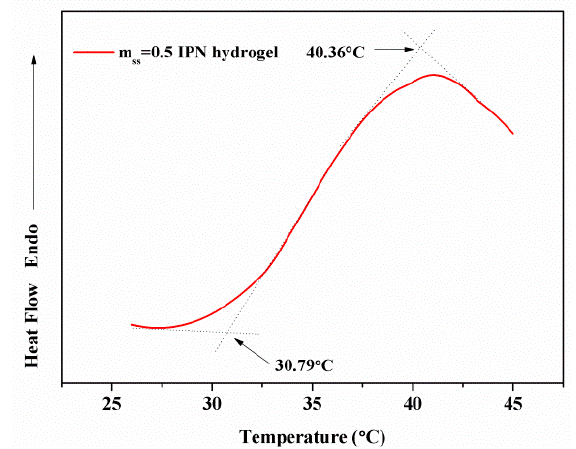
Figure 9. LCST of m ss = 0.5 g hydrogel.